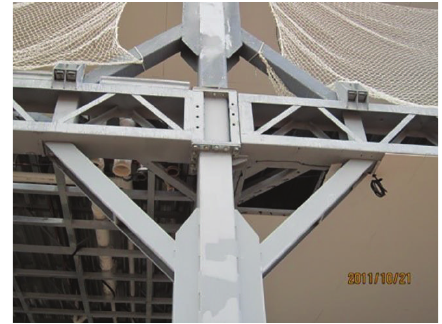
Figure 6: Assembly of modules.